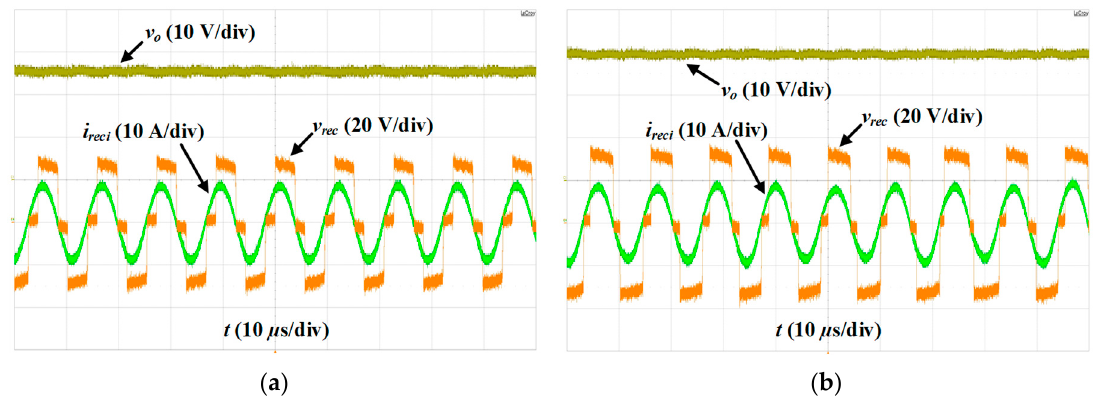
= 25 V; ( b ) V = 30 ref ref